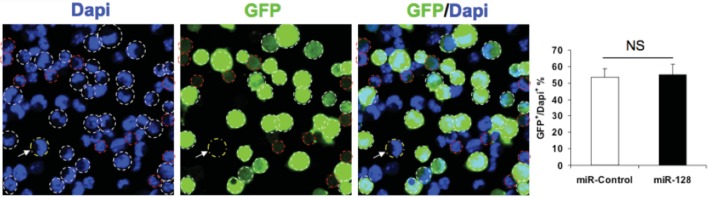
Transfection efficiency of expression constucts.NPCs were electroporated with the indicated plasmids and the nuclei were counterstained with DAPI. White outlines indicate GFP+ cells and red outlines indicate cells have that borderline expression of GFP and considered GFP-negative. White arrow indicates a GFP-negative cell. Quantification of the ratio of GFP-positive cells over total DAPI counterstained cells show the transfection efficiency to be consistent between the miR-128 overexpression construct and its corresponding control. More than 1500 GFP-positive cells were counted for each condition. At least three sets of independent experiments were performed. The values represent the means ± s.d. (n=3). Student’s t-test, differences were considered significant at ***P<0.001.